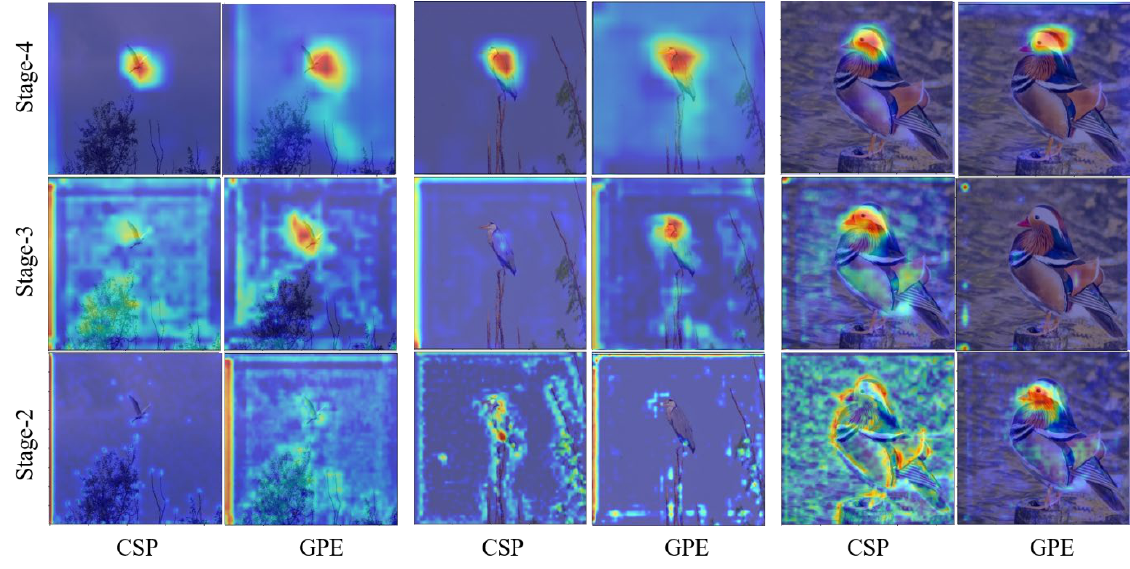
Figure 9. Heat map visualization of attention distribution for GPE module.